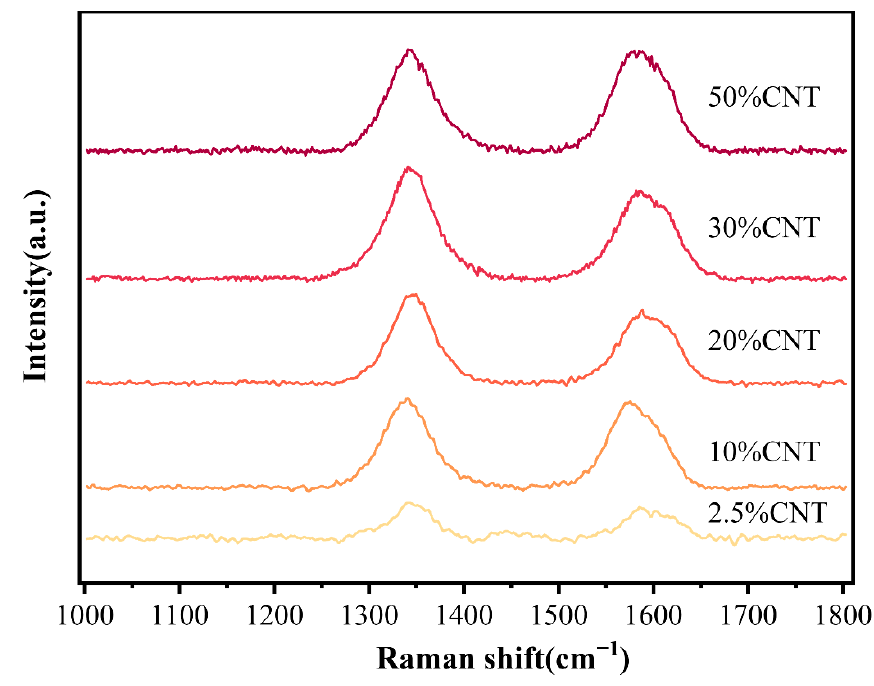
Figure 7. Raman spectra of CNTs/OCWPU with different CNTs content.